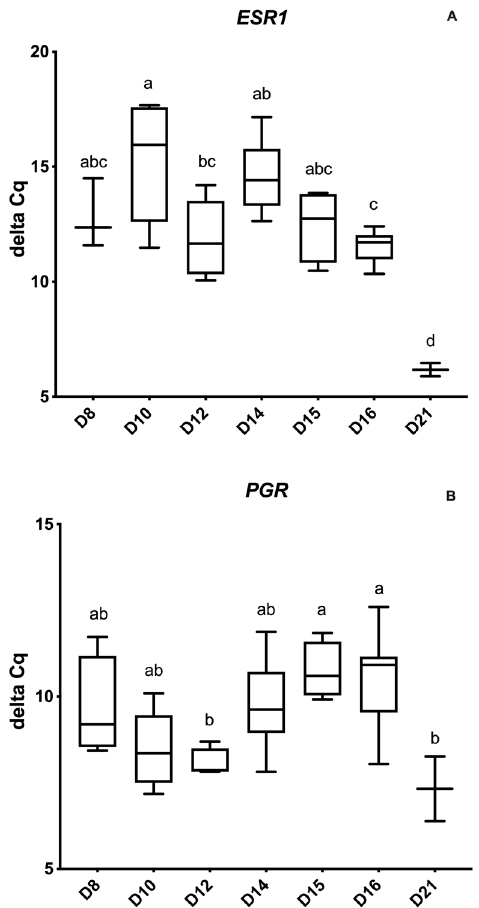
Figure 3. Relative abundance (delta Ct) of steroid hormone receptor genes by embryonic age (Days 8 to 21 post-ovulation); ( A ) Estrogen receptor 1 ( ESR1 ) and ( B ) Progesterone receptor ( PGR ). Delta Ct concentrations have an inverse relationship to mRNA abundance. Differences between days ( p < 0.05) are indicated by the different superscripted letters.